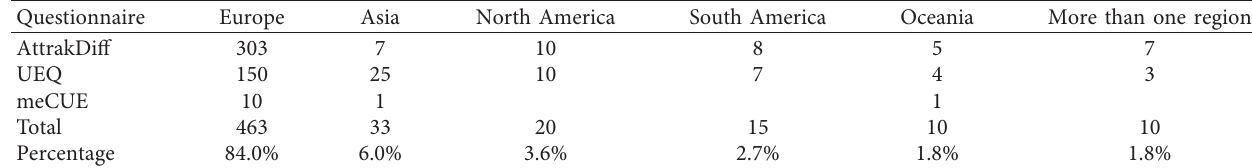
Figure 2: Total uses of standardized questionnaires by year, per questionnaire, and summarizing all three questionnaires. Table 4: Total number of uses of standardized questionnaires by geographical